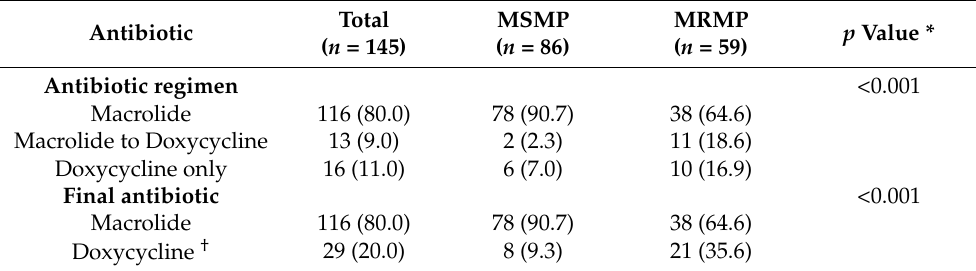
Table 2. Antibiotic treatment in of children with Mycoplasma pneumoniae pneumonia according to macrolide resistance. Antibiotic